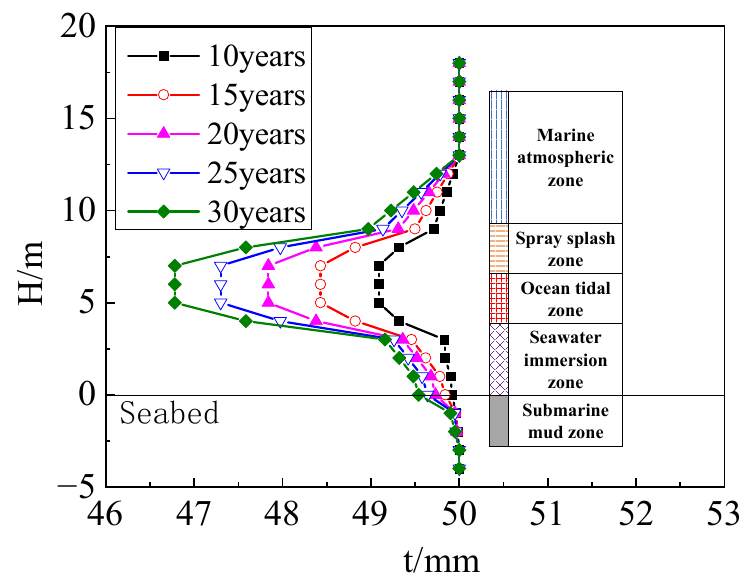
Figure 6. The wall thickness of the tower varies with time.